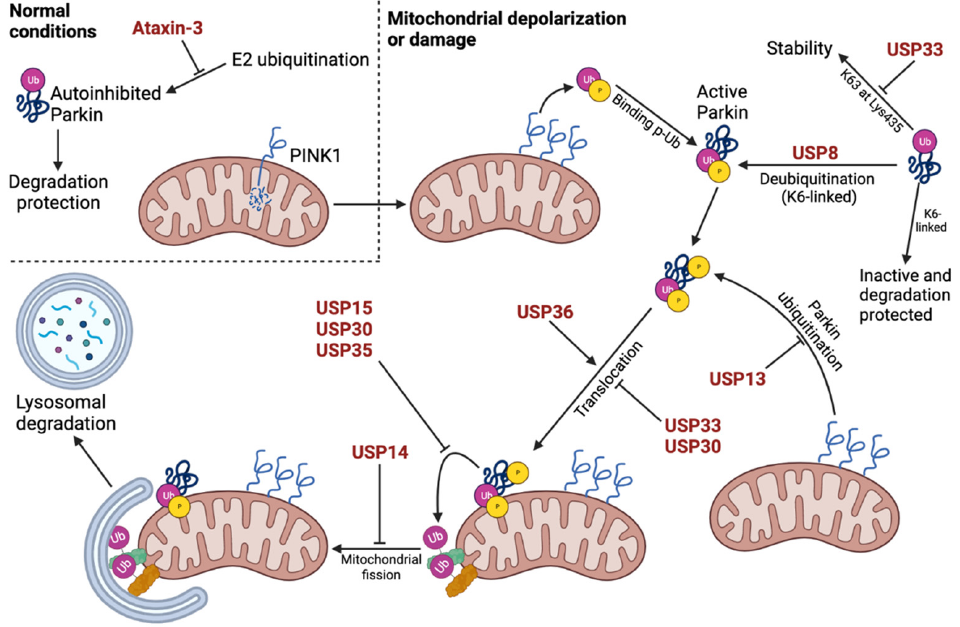
Figure 4. Mitophagy illustration including functions of USP8, USP13, USP14, USP15, USP30, USP33, USP35, USP36, and Ataxin ‐ 3. Ataxin ‐ 3, USP13, and USP8 inhibit the ubiquitination of